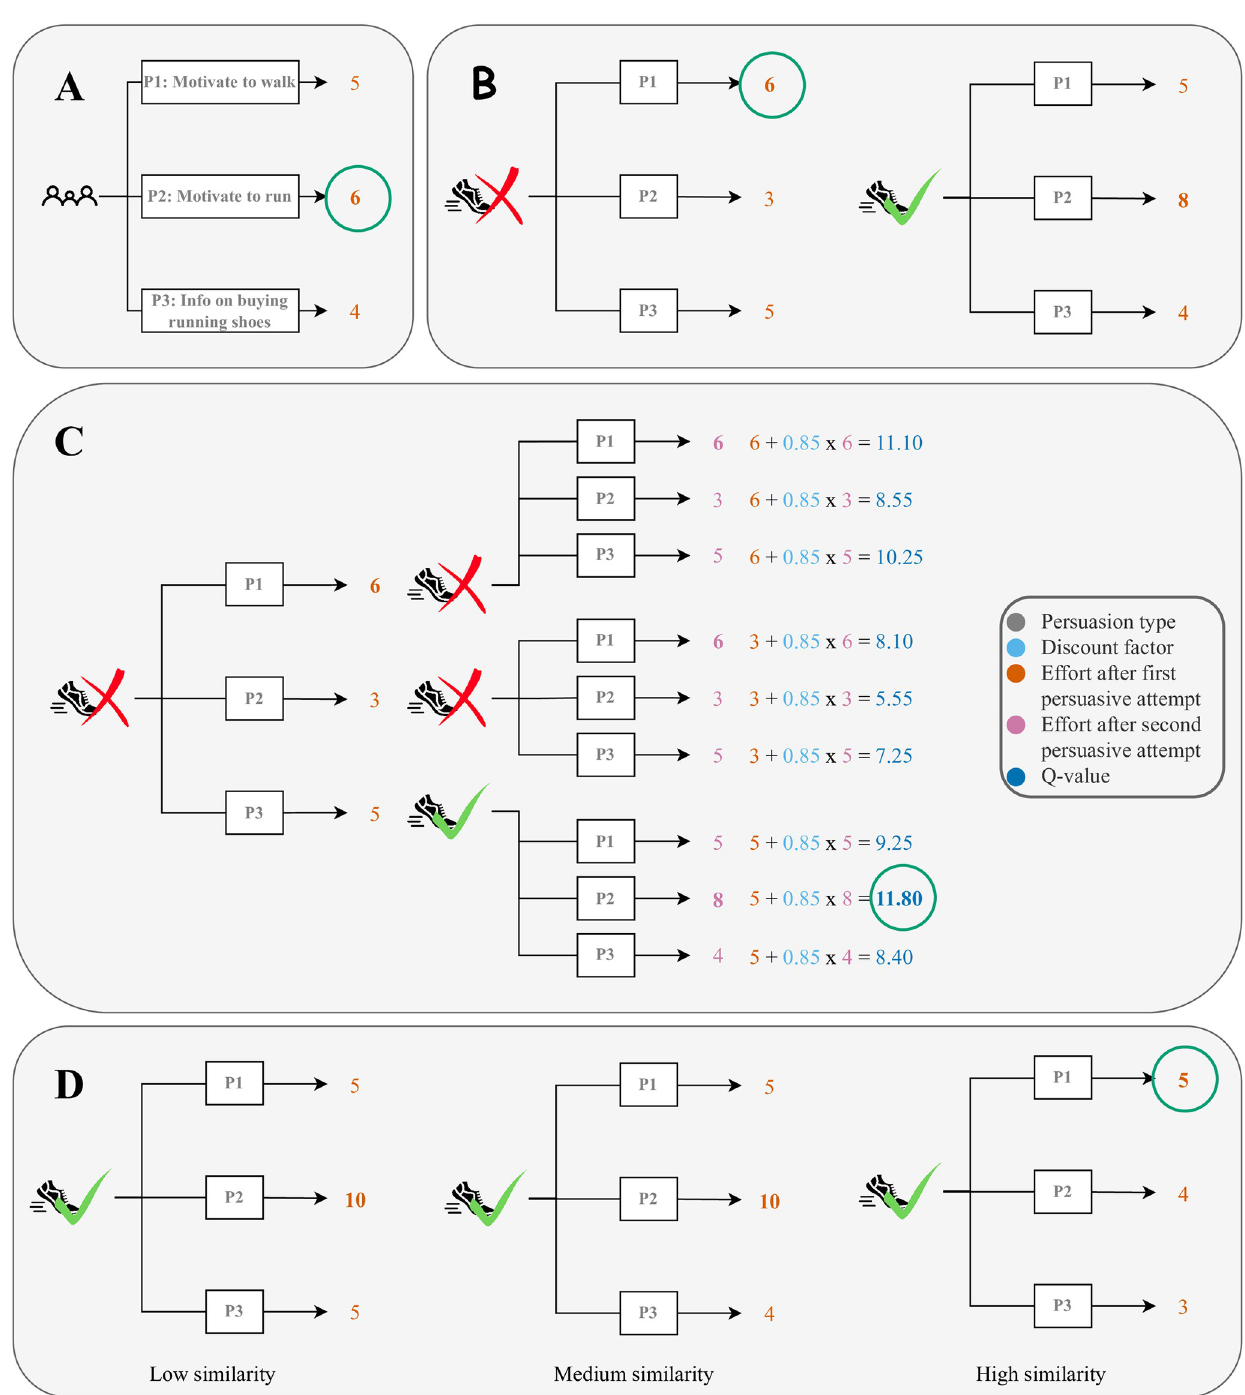
Fig 2. Illustration of the algorithm components. Illustration of our proposed algorithm components. To the baseline of sending the most effective persuasion type (A) we add the consideration of states (B), next states (C), and the similarity of people (D). Circles indicate the most effective persuasion type for the example person Martha described in the